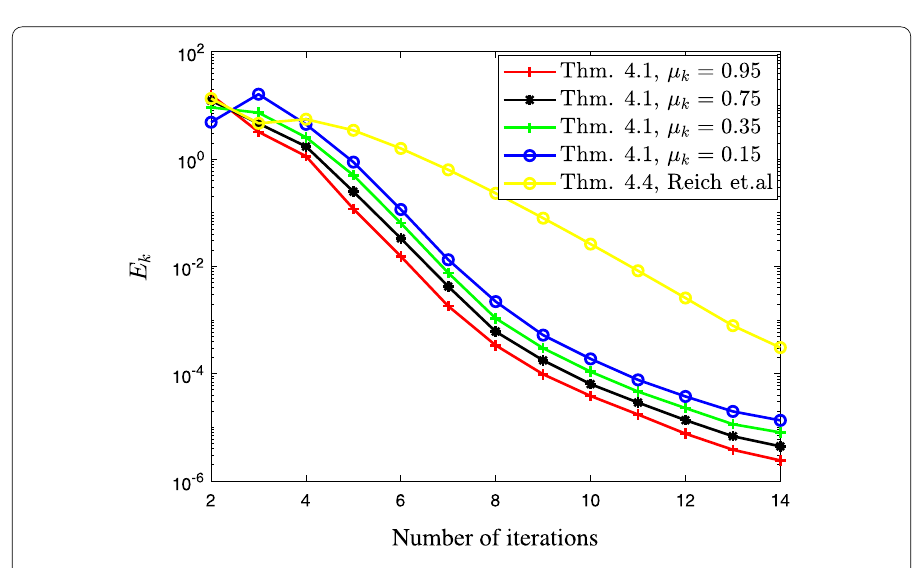
Figure 4 Example 5.1: Case